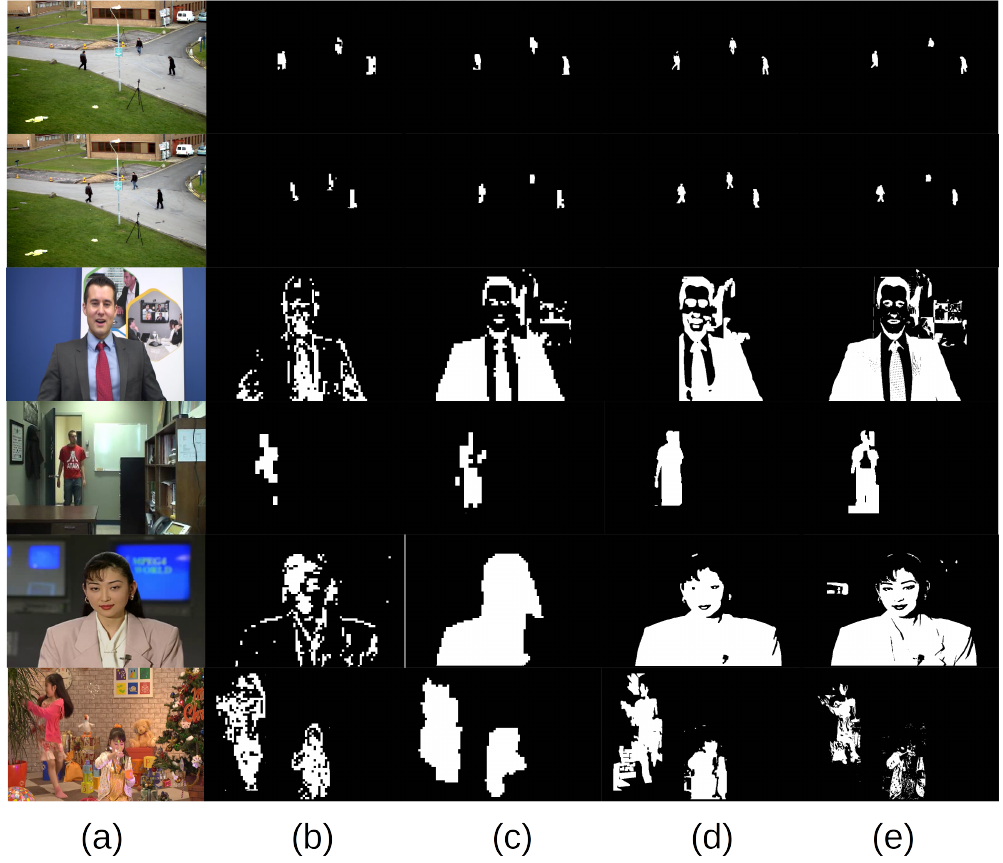
Figure 14. Visual effect comparisons among various motion vector extraction method ( a ) Original sequences (from top to bottom: Pedestrians #3, Pedestrians #15, Johnny #31, Office #18, Akiyo #10, Party